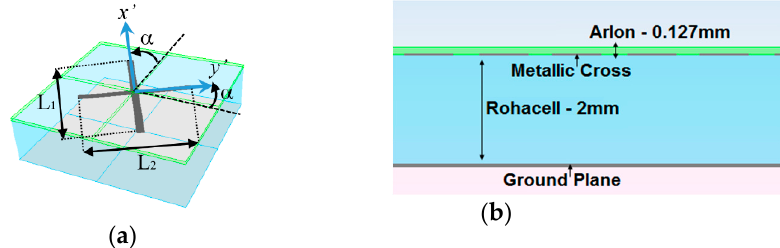
Figure 3. ( a ) Definition of the unit cell. The period is 7.6 mm. The components x ’ and y ’ of the incident field are parallel to the larger and shorter cross arms of the figure. ( b ) Side view of the periodic multilayer structure. The bottom dielectric layer is made of Rohacell material (permittivity ε r = 1.12 and loss tangent tan𝛿 = 0.002 ) and the upper layer is made of Arlon material (permittivity ε r = 2.3 and loss tangent tan𝛿 = 0.002 ). The direction of the impinging plane wave is the – 𝐳(cid:3548)′ direction and its electric field is expressed as: